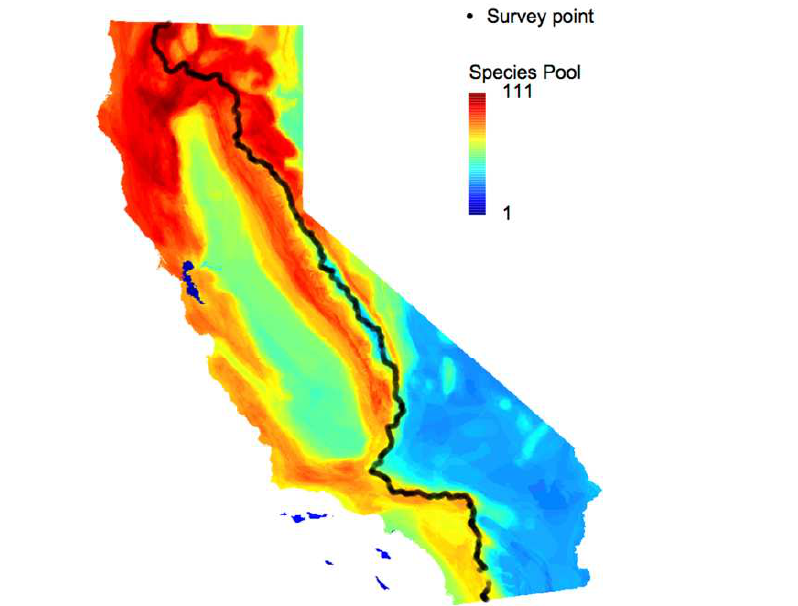
Figure A1 . Available species richness pool for California as derived from expert-based range maps for 155 species detected at least once during surveys along